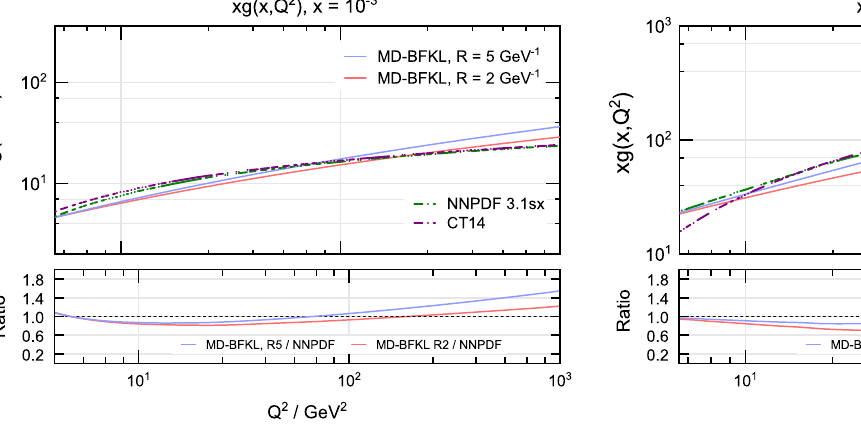
2 GeV − 1 (at “hot-spots” within proton disk). Theoretical prediction is compared with global datasets NNPDF 3.1sx and CT 14